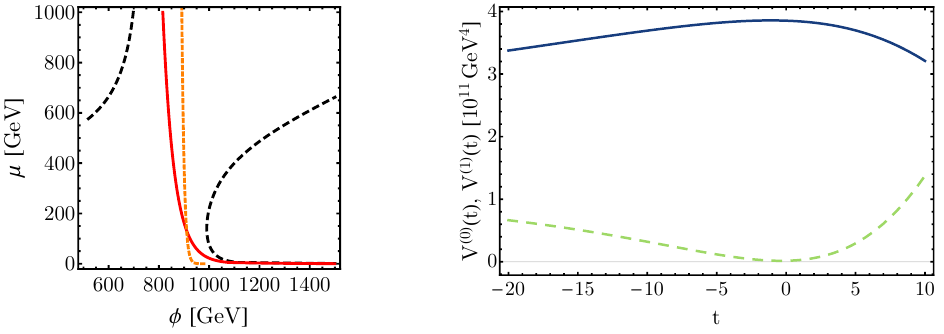
Figure 7 . Left panel: the V (1) = 0 (black dashed line) and B = 0 (red solid line) hypersurfaces, the short-dashed orange line is a characteristic curve passing throug a point with (cid:30) = 900 GeV and (cid:22) = 400 GeV for t = 0. Right panel: the tree-level potential (blue solid line) and the one- loop correction (green dashed line) plotted as a function of t with the same initial conditions as the characteristic curve from the left panel. The minimal value of the one-loop correction is V (1) = 1 : 5 (cid:1) 10 9 GeV 4 and is attained for t = (cid:0) 0 :